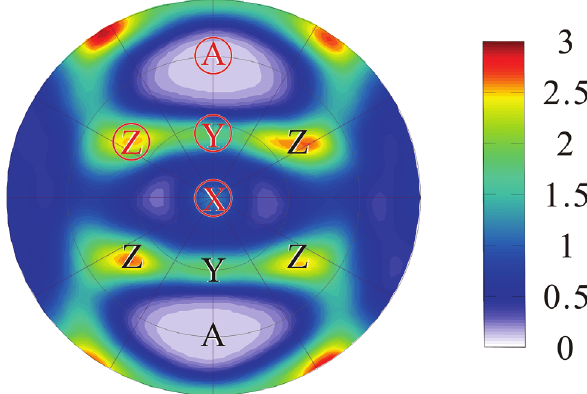
Figure 6: A {100} complete pole figure of pure copper at a cold rolling of 75% reduction. The symbols X, Y, Z, and A designate the cube, copper, brass, and non-texture components, respectively.